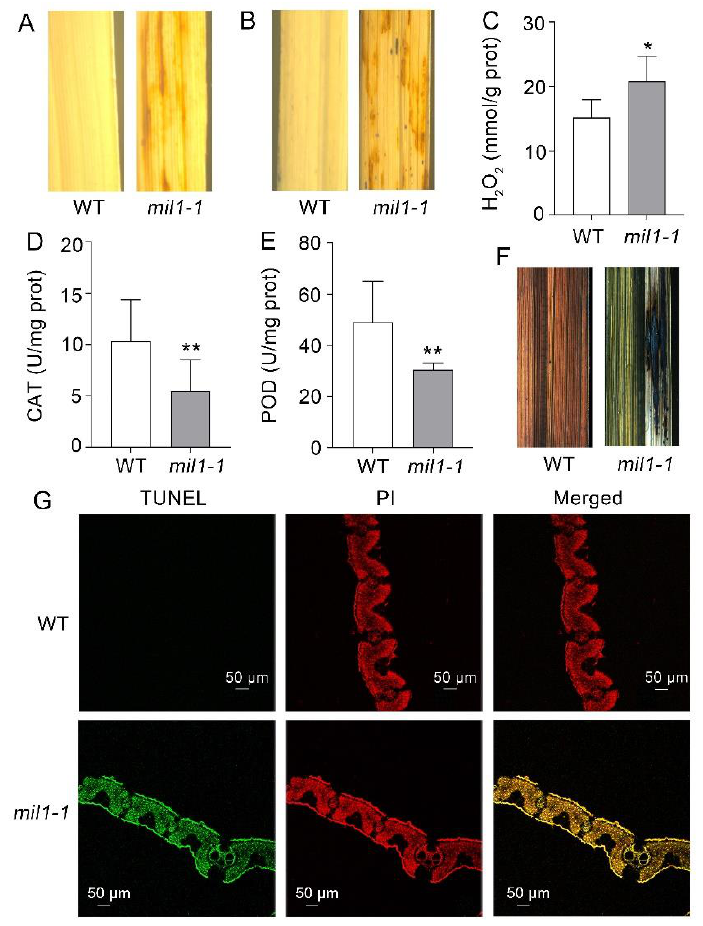
Figure 2. Histochemical analysis of ROS accumulation and cell death in WT and mil1-1 . ( A ) DAB staining of leave in WT and mil1-1 . ( B ) NBT staining of leave in WT and mil1-1 . ( C ) H 2 O 2 concentration in WT and mil1-1 . ( D , E ) Enzyme activities of CAT ( D ) and POD ( E ) in WT and mil1-1 . Data in ( C – E ) are means ± SD. prot: protein. U: unit. Three biological replicates were performed in the measurement ( n = 3). A two-tailed unpaired t-test with Welch’s correction is used for statistical analysis. Asterisks indicate significant differences between treatments and respective controls at each time point (* p < 0.05, ** p < 0.01; Student’s t test). ( F ) Trypan blue staining of WT and mil1-1 leaves. ( G ) DNA fragments detected by TUNEL assay. Scale bar is 50 µ m. ROS: reactive oxygen species; DAB: diaminobenzidine; NBT: nitro-blue tetrazolium chloride; CAT: catalase; POD: peroxidase; TUNEL: terminal deoxynucleotidyl transferase-mediated dUTP nick-end labeling; PI: Propidium Iodide.